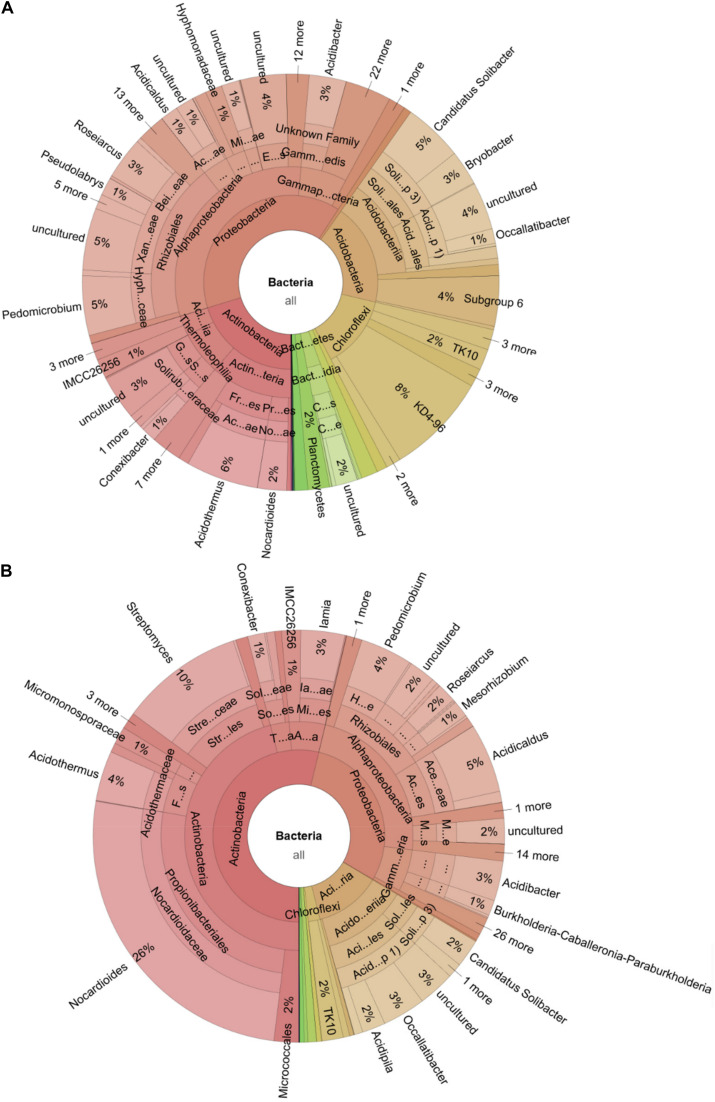
Microbiome shift during the spreading of a fungal infection in a C. testaceus carton nest. The Krona chart shows the microbiome of the infected nest material during (A) the early and (B) the late stage of infection. The abundance of Acidobacteria and Chloroflexi during the early stage of infection was significantly higher compared to a healthy nest microbiome. The abundance of Streptomyces (early 0.03–10% late), Acidobacteria (early 19–12% late) and Nocardioides (early 2–26% late) was higher compared to the healthy nest material. The abundance of phylum Chloroflexi decreased from 14 to 2% from the early to the late infection stage.